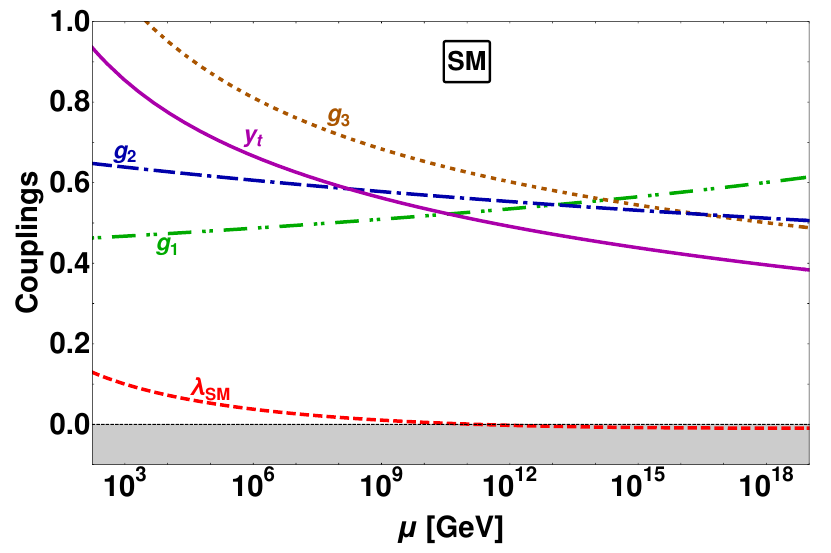
Figure 1 . The renormalization group evolution of the SM gauge couplings g 1 , g 2 , g 3 , the top quark Yukawa coupling y and the quartic Higgs boson self-coupling λ t